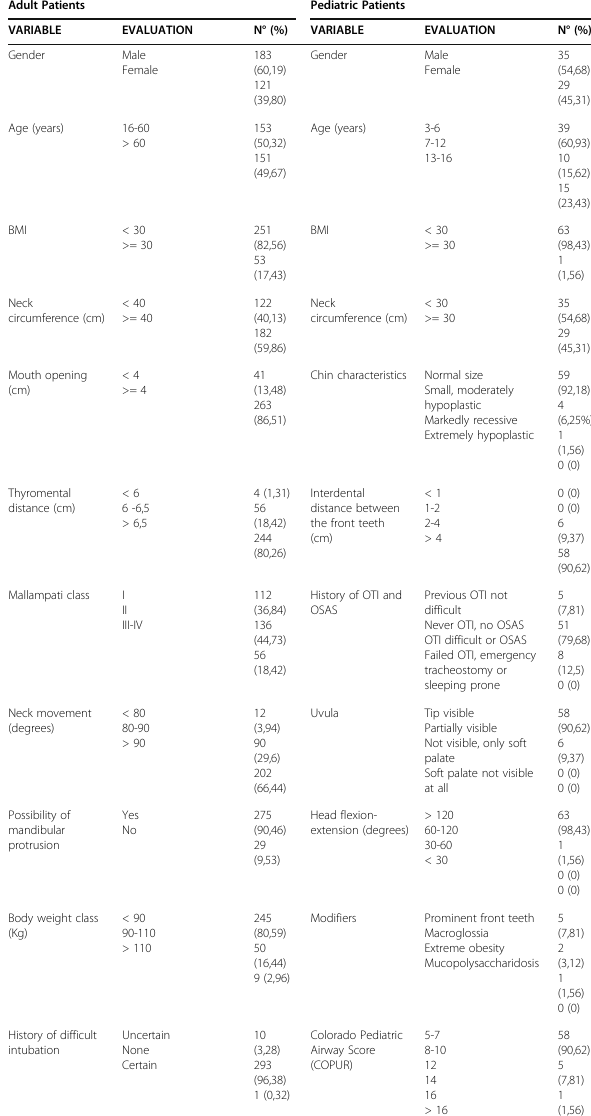
Table 1 (abstract A168). Results